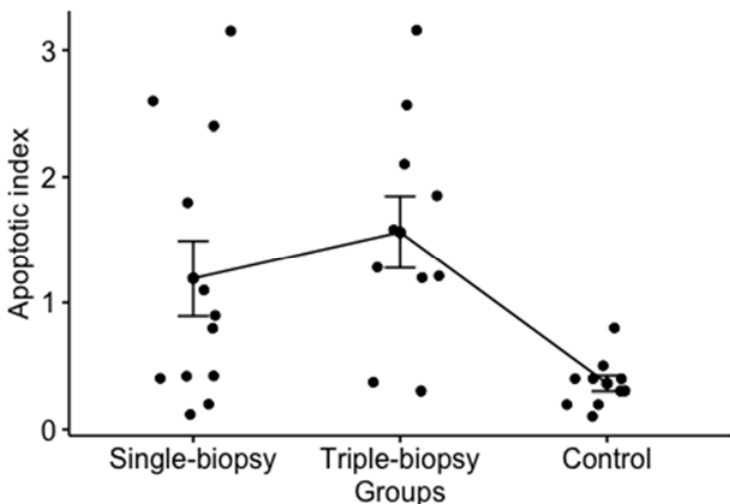
Figure 5. Left testis sperm count analysis (Kruskal-Wallis test; p < 0.05).